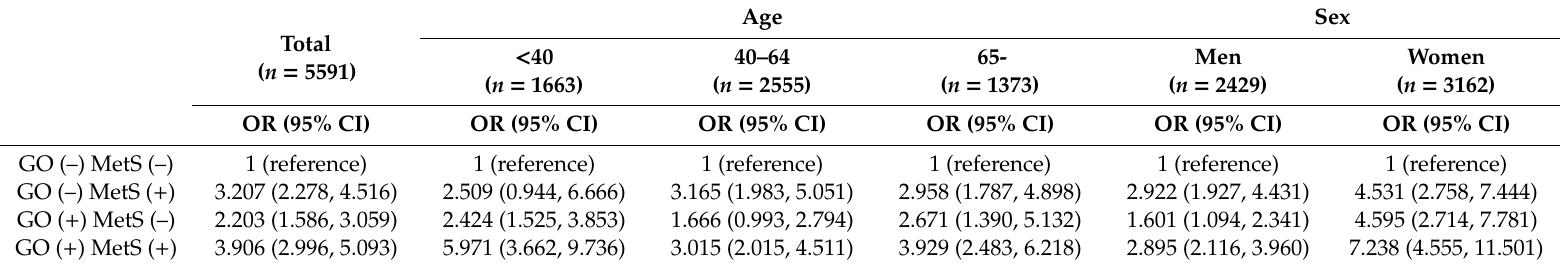
Table 4. The odds ratios for the presence of hyperuricemia according to presence of metabolic syndrome and general